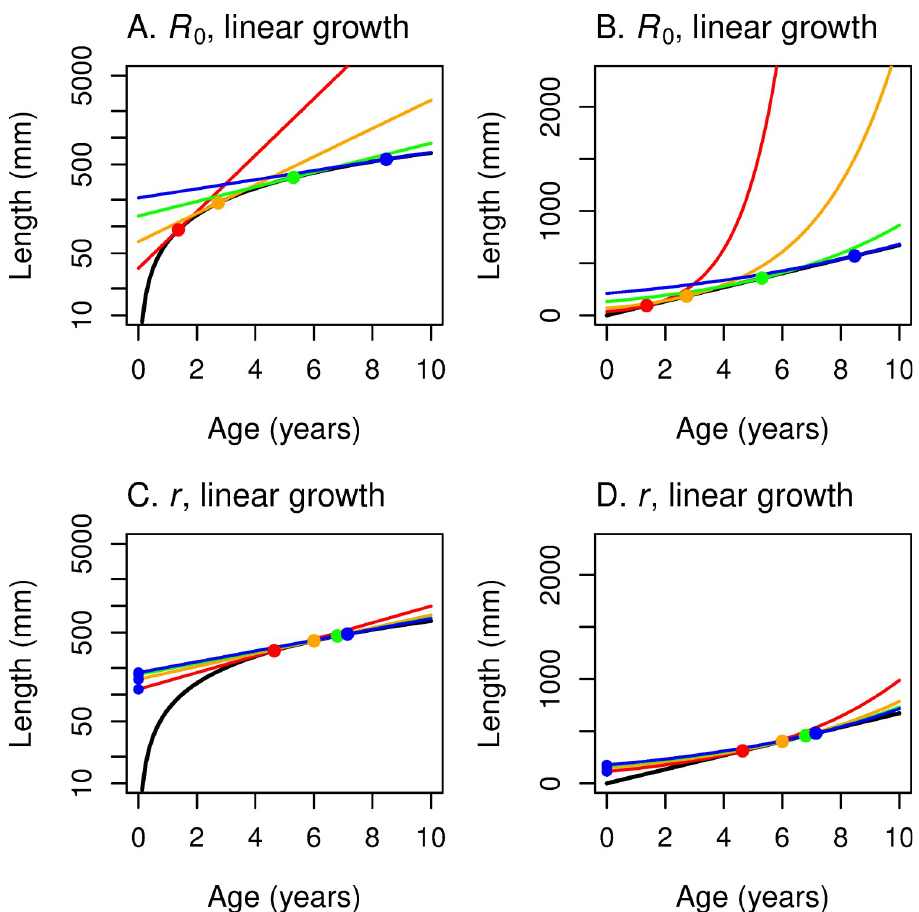
Fig 9. Given a linear growth trajectory, increasing survival increases optimal maturation age and size. As annual survival s increases, the growth curve is unchanged, but the iso-fitness curves become less steep and the age-0 intercepts increase (see Fig 8), so optimal age and length increase along the growth curve. From this point of view the reaction norm curve is the same as the growth curve. Colored lines show level sets of fitness function R 0 in (A, B) and level sets of r in (C, D); corresponding colored points show optimal age and length to maximize the fitness function for each level of annual survival rate s (red: 0.25, orange: 0.50, green: 0.70, blue: 0.80). This linear growth trajectory has k = 266.2 mm/yr, c = 0. (A, C) With log-length on the vertical axis, iso-fitness lines are straight. (B, D) With linear length on the vertical axis, the linear growth curve is a straight line, but iso-fitness lines are